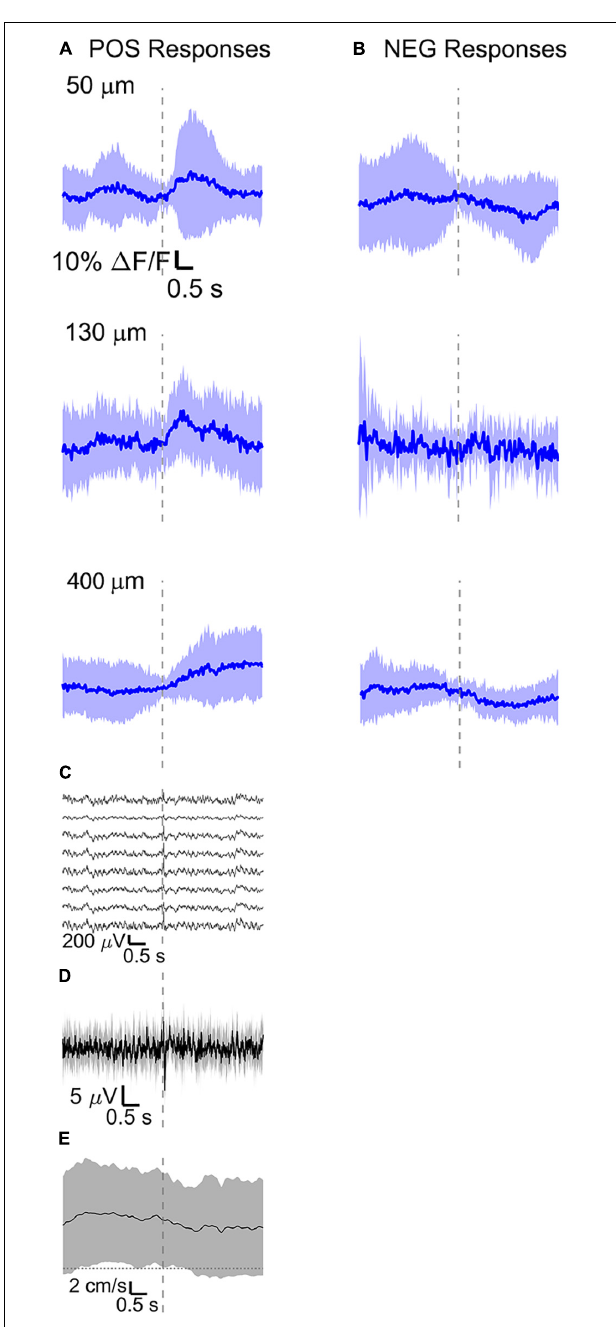
FIGURE 7 | Average calcium signal at three different depth and LFP, both in barrel cortex, ECoG, and running speed in response to a facial air puff (four awake mice during running). Average calcium signals recorded from three different depths in awake mice during running, separated in (A) positive (4 mice, 50 µ m: 24 trials, 32 ROIs; 130 µ m: 9 trials, 37 ROIs; 400 µ m: 25 trials, 30 ROIs) and (B) negative signals (4 mice, 50 µ m: 24 trials, 24 ROIs, 130 µ m: 9 trials, 12 ROIs, 400 µ m: 25 trials, 28 ROIs). (C) Corresponding average LFP recorded by eight electrodes (every 4th channel of the linear probe, tip at 850 µ m below dura, bottom LFP trace: 800 µ m, top LFP trace: 100 µ m below dura, (cid:49) depth = 68 µ m between adjacent traces. Corresponding (D) average ECoG and (E) average speed. All traces are plotted as mean ± standard deviation. Gray dashed line marks the air puff